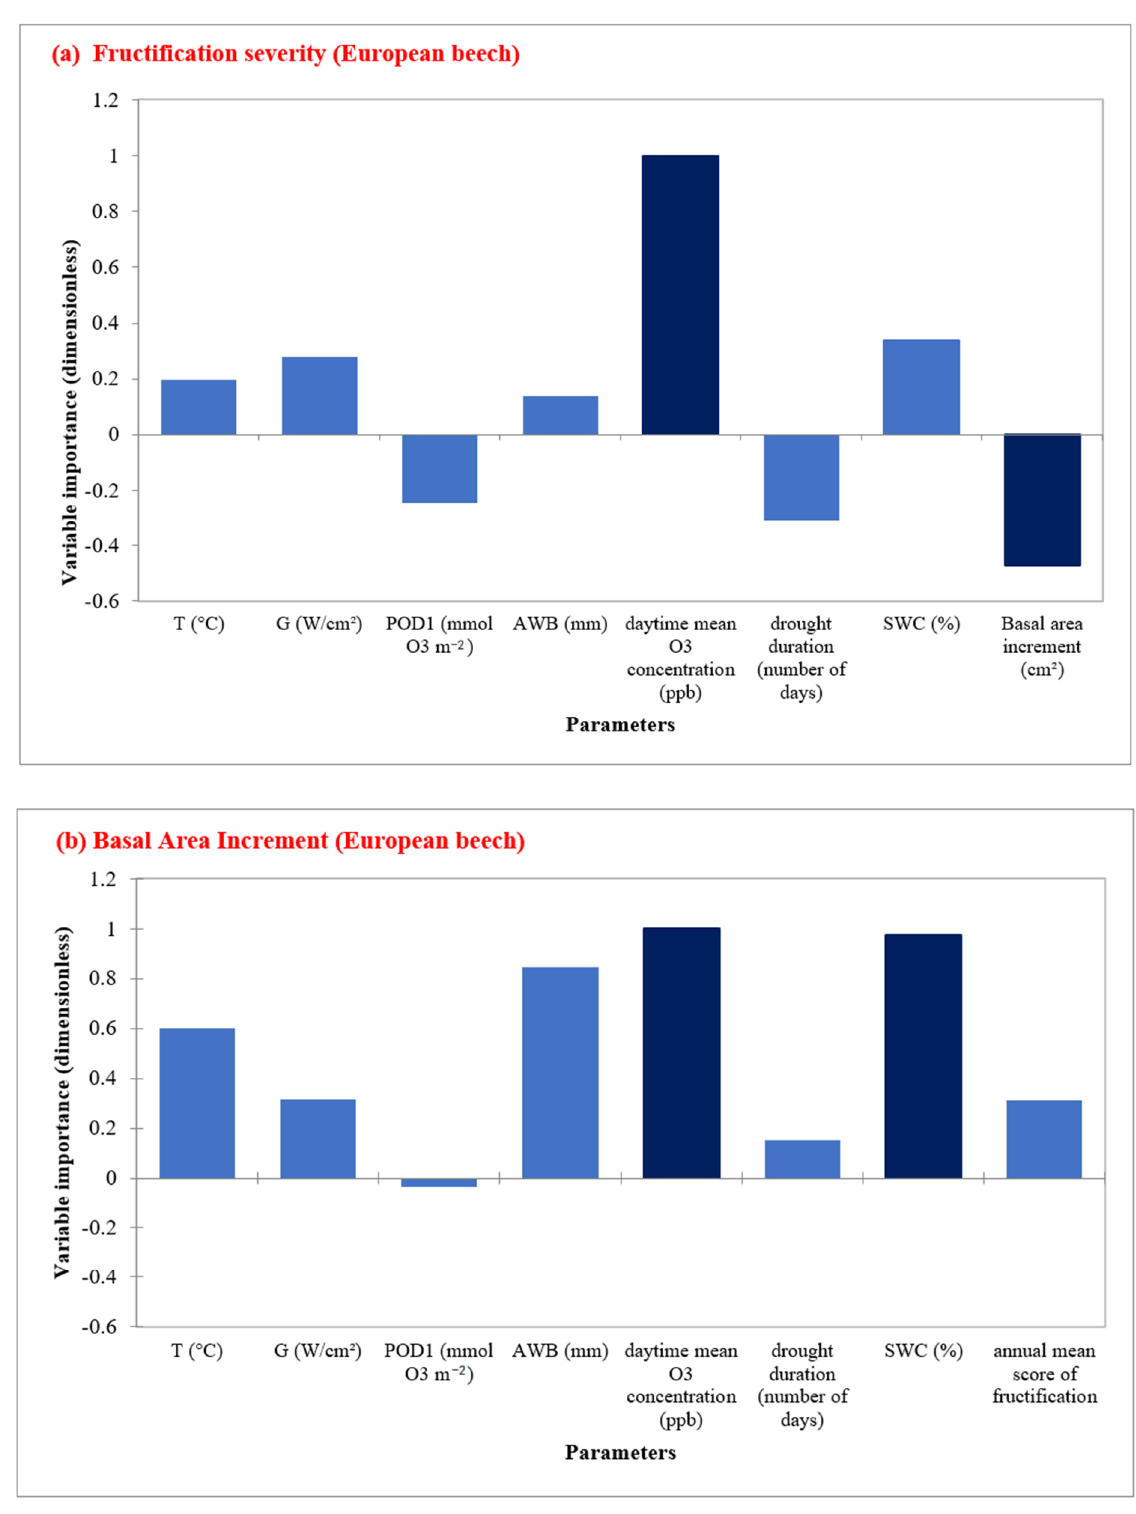
Figure 5. Random Forest Analysis for European beech showing the most important predictors in determining ( a ) fructification severity, and ( b ) Basal area increment in five sites during the time period 1998–2019.